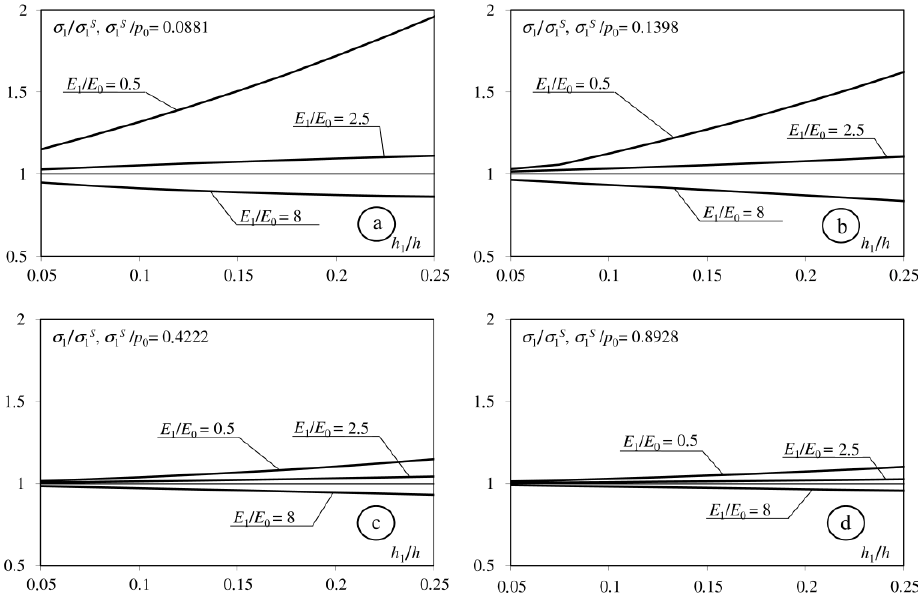
Figure 5. Dependence of the maximum tensile stress on the surface of the considered half-space to the h 1/ h parameters. ( a ): f = 0; ( b ): f = 0.1; ( c ): f = 0.25; ( d ): f = 0.5), h = 0.8; E 2 / E 0 = 4.